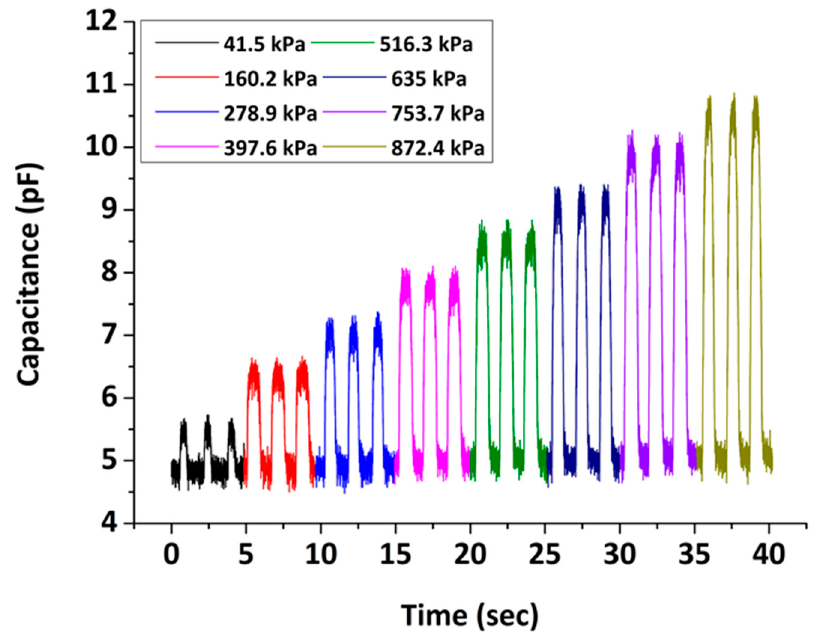
Figure 5. Real-time capacitance response of a typical 3D-printed capacitive pressure sensor at different external pressures under three loading/unloading cycles.